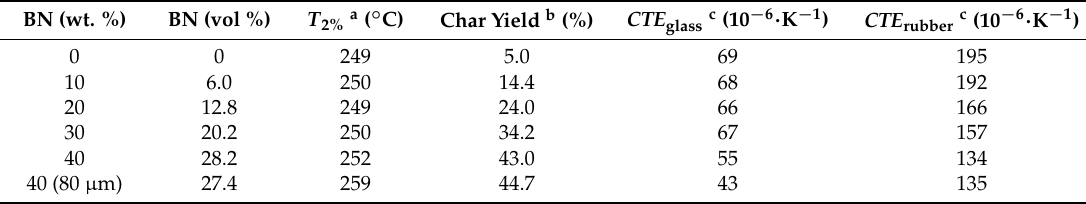
Table 3. Thermal data of composites extracted from TGA and TMA analysis.